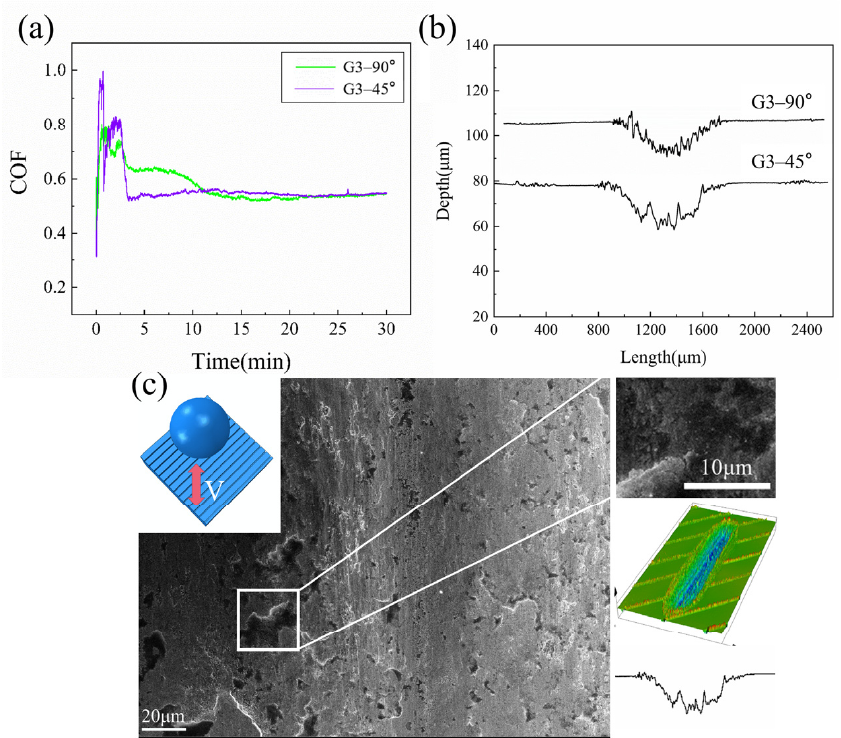
Figure 13. The ( a ) COF, ( b ) wear section and area, and ( c ) SEM and LCM morphologies of G3 in the 45° and 90° friction direction when sliding with Si 3 N 4 .